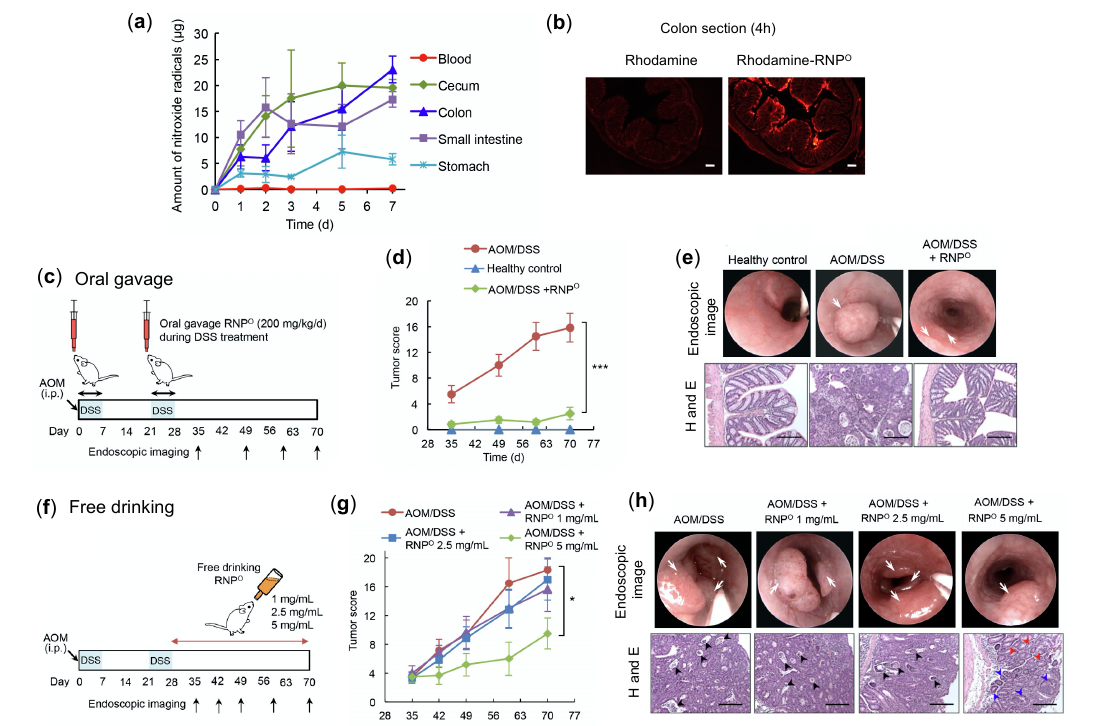
Figure 6. Anti-tumor effect of RNP O in colitis-induced colon cancer (CAC) model. ( a ) Accumulation of RNP O in the gastrointestinal tract by ad libitum drinking, assessed by ESR measurement [105]. ( b ) Localization of rhodamine-labeled RNP O (rhodamine-RNP O ) in the colon section, 4 h after the oral administration with 5 mg/mL of rhodamine-RNP O (1 mL), scale bar 200 μ m [106]. ( c ) The scheme showing anti-tumor effect (protective) of orally administered RNP O in azoxymethane (AOM) and dextran sodium sulfate (DSS) (AOM/CAC) induced colitis-associated cancer in mice. RNP O (200 mg/kg/d) was administered by oral gavage during the two weeks of the DSS treatment period. ( d ) RNP O inhibits the formation of colon tumor, confirmed by tumor score and assessed by endoscopy. ( e ) The endoscopic imaging of mice colon, displaying tumor shown by white arrows and H and E-stained colon tissues (scale bar 100 μ m) at the experimental endpoint (day 70). ( f ) The scheme showing anti-tumor effect (therapeutic) of ad libitum drinking of RNP O in AOM/CAC-induced colitis-associated cancer in mice. RNP O (1, 2.5, and 5 mg/mL) was available as ad libitum drinking after AOM/DSS treatment. ( g ) The therapeutic effect of RNP O to inhibit the formation of colon tumor as confirmed by tumor score, which was assessed by endoscopy. ( h ) The endoscopic imaging of mice colon, displaying tumor shown by white arrows and H and E stained colon tissues (scale bar 100 µ m), at the experimental endpoint (day 70). Black arrows in H and E colon stained tissues indicate the necrotic cells surrounded by cancer cells, blue arrows indicate adenoma, and red arrows display normal crypts [105]. * p < 0.05 was considered significant. This figure is reproduced with permission from References [105,106]. Copyright